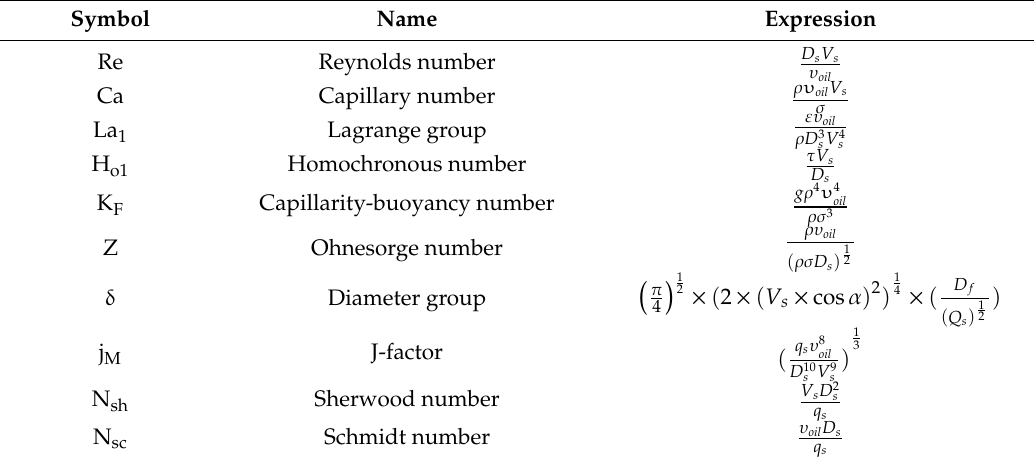
Table 4. The dimensionless groups associated with Equation (11) based on the physical chemistry handbook [31].